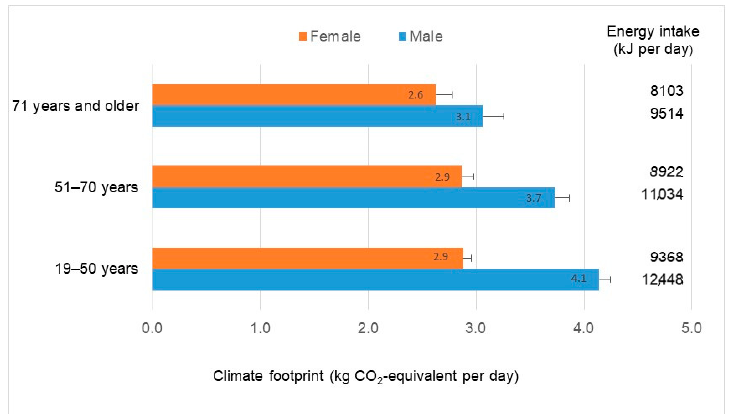
Figure 1. The climate footprint and energy intake of Australian adult diets based on 9341 individual daily diets reported in the Australian Health Survey. Bars show 95% confidence intervals.